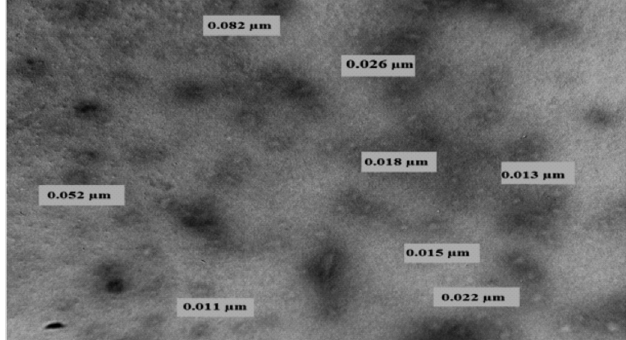
FIGURE 6 - Transmission electron microscopic positive image of glycyrrhizin nanoemulsion showing the size of some